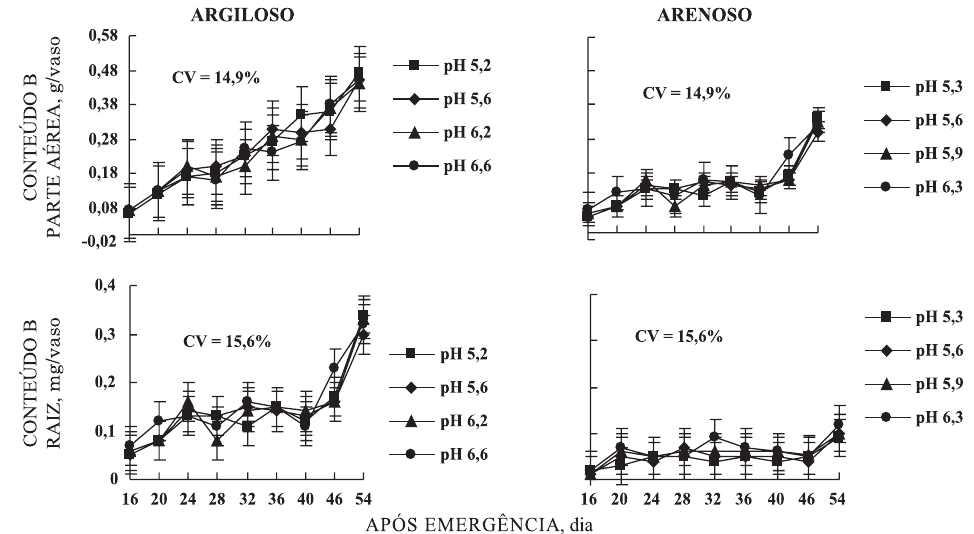
Figura 4. Conteúdo de boro da matéria seca da parte aérea e do sistema radicular de plantas de soja, em diferentes épocas de avaliação após a emergência, em relação ao pH inicial do solo argiloso e do arenoso.